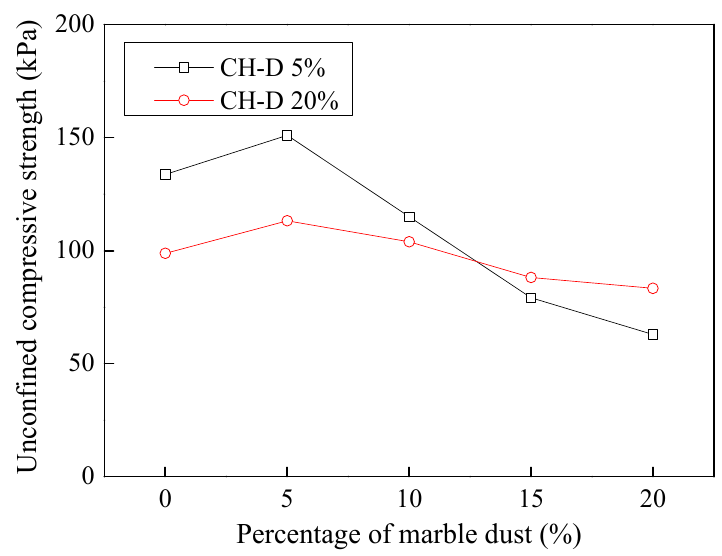
Figure 22. Improvement in dyeing effluent contaminated CH soil using marble dust. Processes 2018 , 6 , x FOR PEER REVIEW